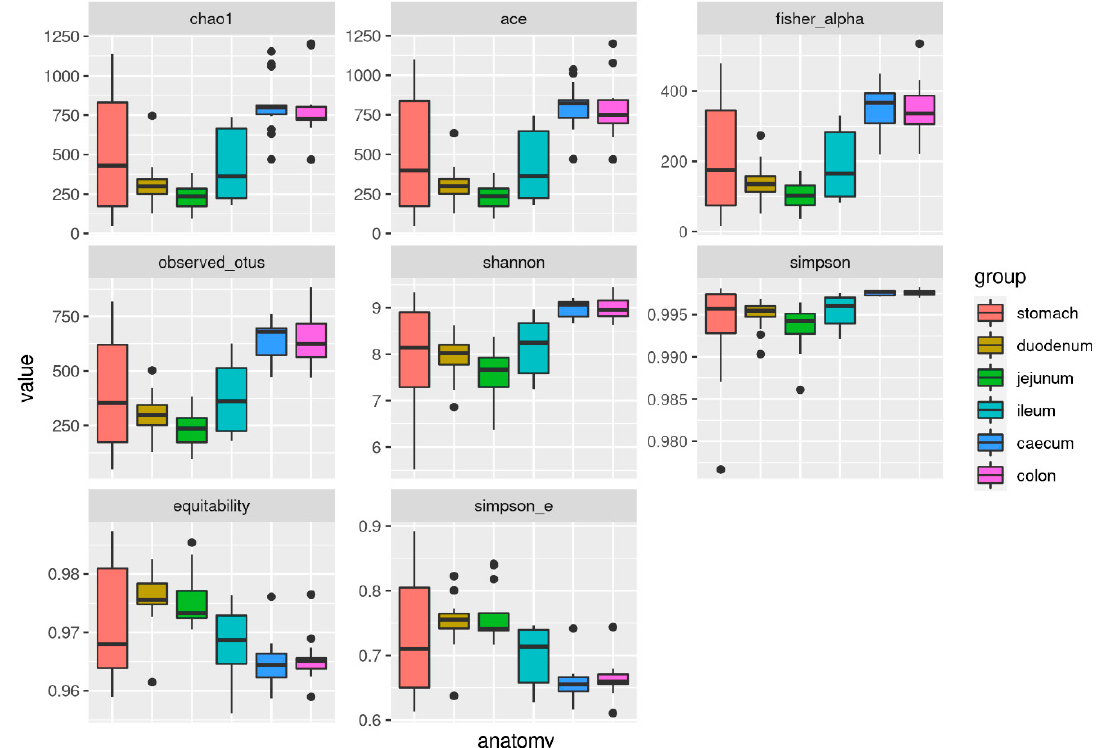
Figure 4. Alpha diversity indexes. Boxplots of alpha diversity indexes (Chao1, ACE, Fisher’s alpha, number of observed OTUs, Shannon diversity, Simpson diversity, equitability, Simpson E) along the different regions of the rabbit gastrointestinal tract.